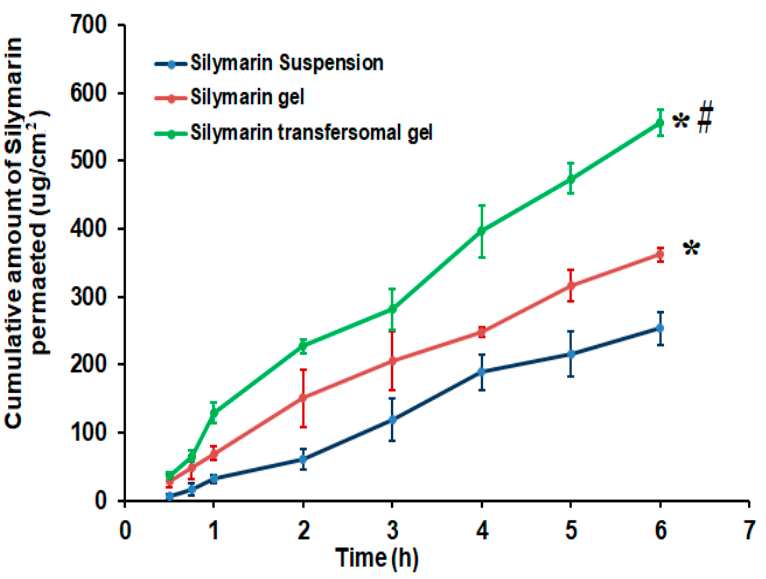
Figure 7. Permeation study of Silymarin from different formulations through excised rat skin compared to Silymarin suspension. Results are expressed as mean ± SD ( n = 3). * ( p < 0.05) compared to Silymarin suspension; # compared to Silymarin gel.